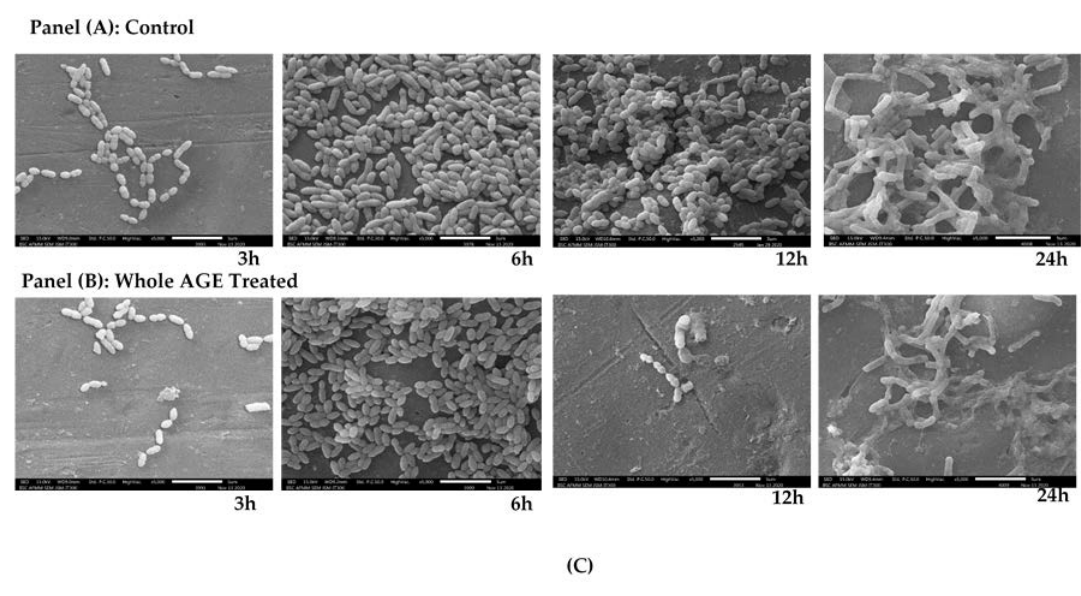
Figure 5. ( A ) Scanning Electron Microscopic Images of C. albicans M207 at different time intervals. Panel (A): Control at 3, 6,12, 24 h; Panel (B): Whole AGE Treated (1 mg) at 3, 6, 12, 24 h. All images were captured at 5000 × magnification. ( B ) Scanning Electron Microscopic Images of E. coli ATCC 39936 at different time intervals. Panel (A): Control at 3, 6, 12, 24 h; Panel (B): Whole AGE Treated (1.25 mg) at 3, 6, 12, 24 h. All images were captured at 5000 × magnification. ( C ) Scanning Electron Microscopic Images of C. albicans M207+ E. coli ATCC 39936 at different time intervals. Panel (A): Control at 3, 6,12, 24 h; Panel (B): Whole AGE Treated (1.25 mg) at 3, 6, 12, 24 h. All images were captured at 5000 ×